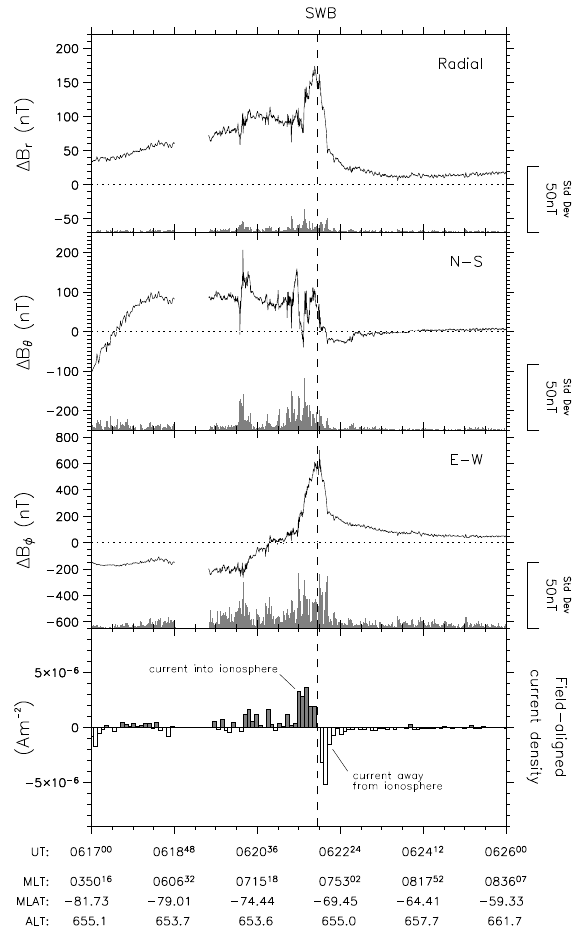
Fig. 3. (Top three panels): Three components of high-time resolution magnetic field observations from the Oersted satellite around the crossing of the spectral width boundary, from 06:17 to 06:26 UT. Grey-shaded bars at the bottom of each panel display the standard deviation of the variation calculated for every 2seconds in duration (i.e. 50 samples). The vertical dashed line indicates the time when the Oersted crosses the spectral width boundary. (Bottom panel): Time-series of field-aligned current (FAC) density calculated from the transverse magnetic field variations for every